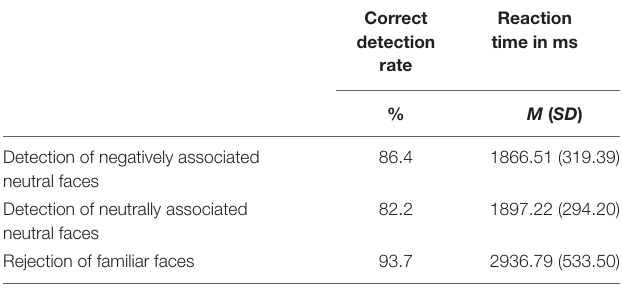
TABLE 5 | Bivariate Pearson correlation coefficients of different types of maltreatment and the indices of the FIC recognition task ( N = 67). Negative Neutral Negative vs. stimuli